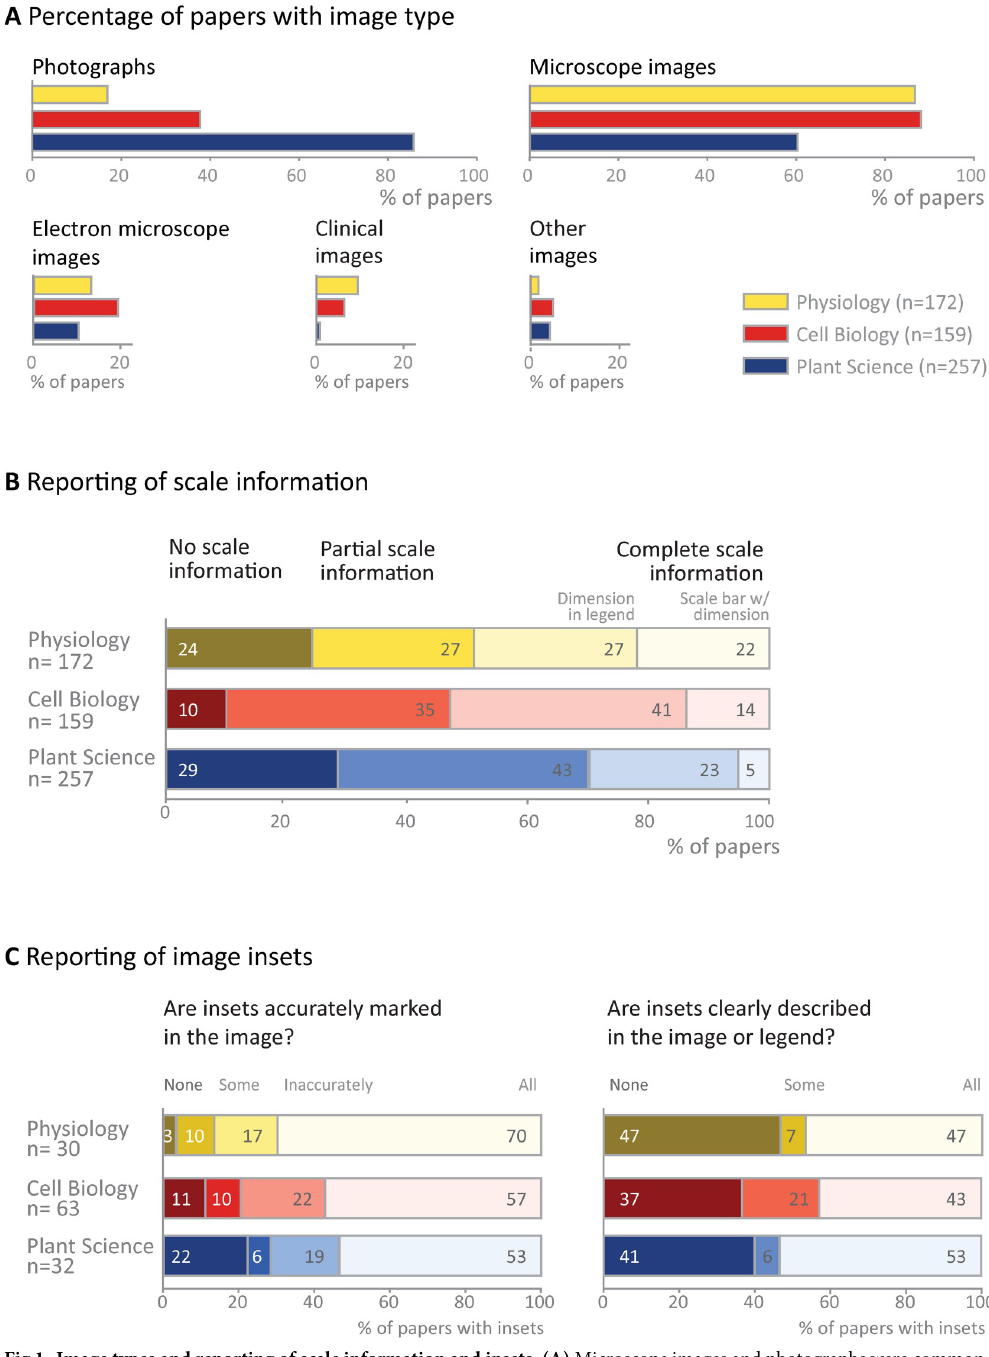
Fig 1. Image types and reporting of scale information and insets. (A) Microscope images and photographs were common, whereas other types of images were used less frequently. ( B) Complete scale information was missing in more than half of the papers examined. Partial scale information indicates that scale information was presented in some figures, but not others, or that the authors reported magnification rather than including scale bars on the image. ( C) Problems with labeling and describing insets are common. Totals may not be exactly 100% due to